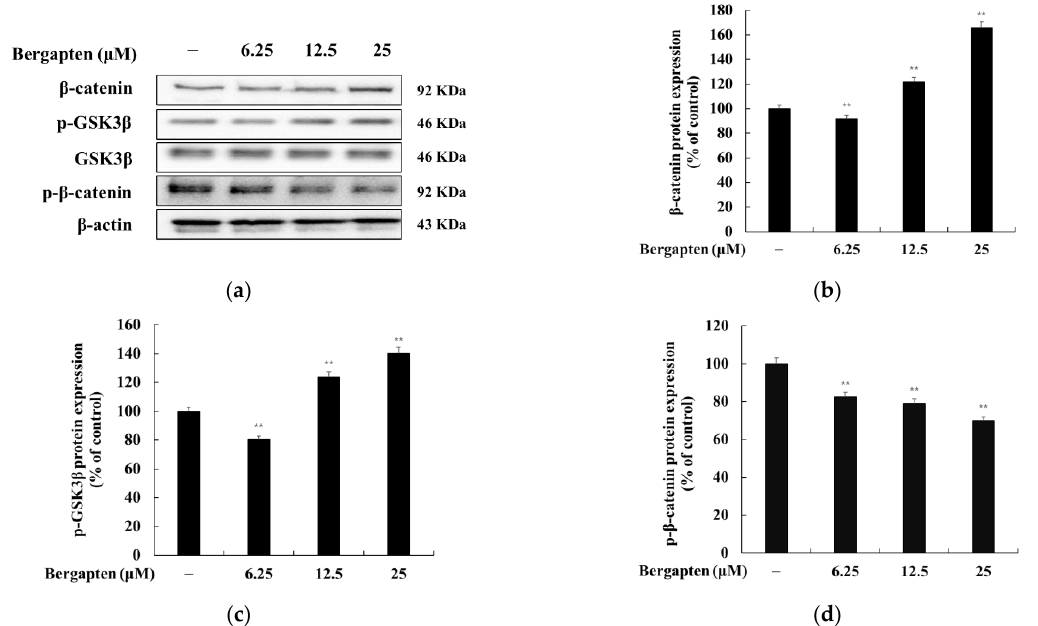
Figure 6. Effects of bergapten on the protein expression level of β -catenin, p- GSK3β , and p- β -catenin in B16F10 melanoma cells. The cells were treated with bergapten (6.25, 12.5, and 25 μM) for 24 h. ( a ) Western blotting results and protein expression of ( b ) β -catenin, ( c ) P- GSK3β/T - GSK3β , and ( d ) P- β - catenin. β -actin was used as a loading control. The results are presented as the mean ± SD of three independent measurements using Image J. ** p < 0.01 vs. the untreated group.